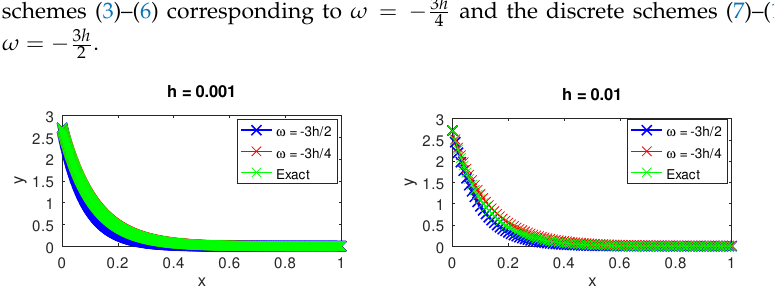
3 h and the discrete schemes (7)–(10) corresponding to 4 −